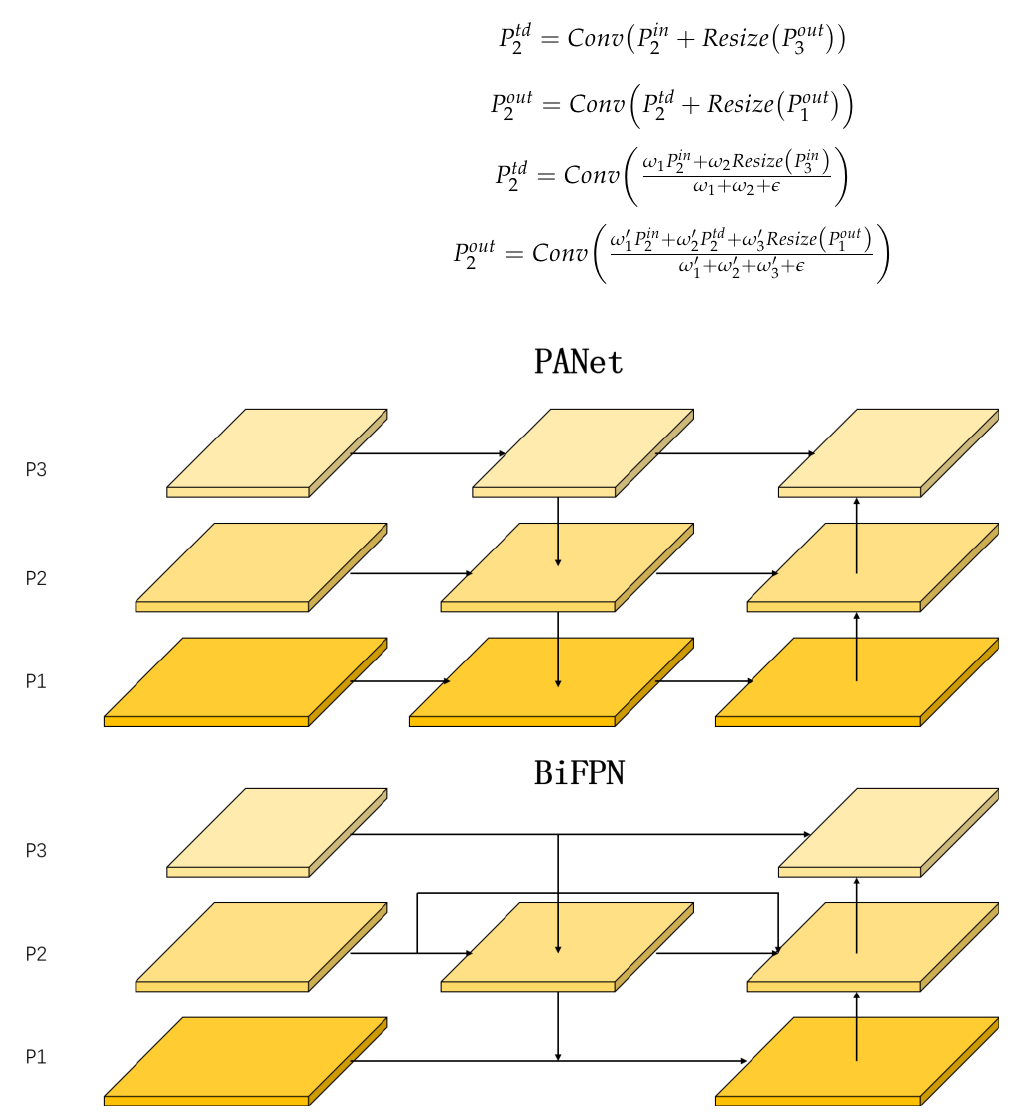
Figure 12. Diagram of the structure of PANet and BiFPN.